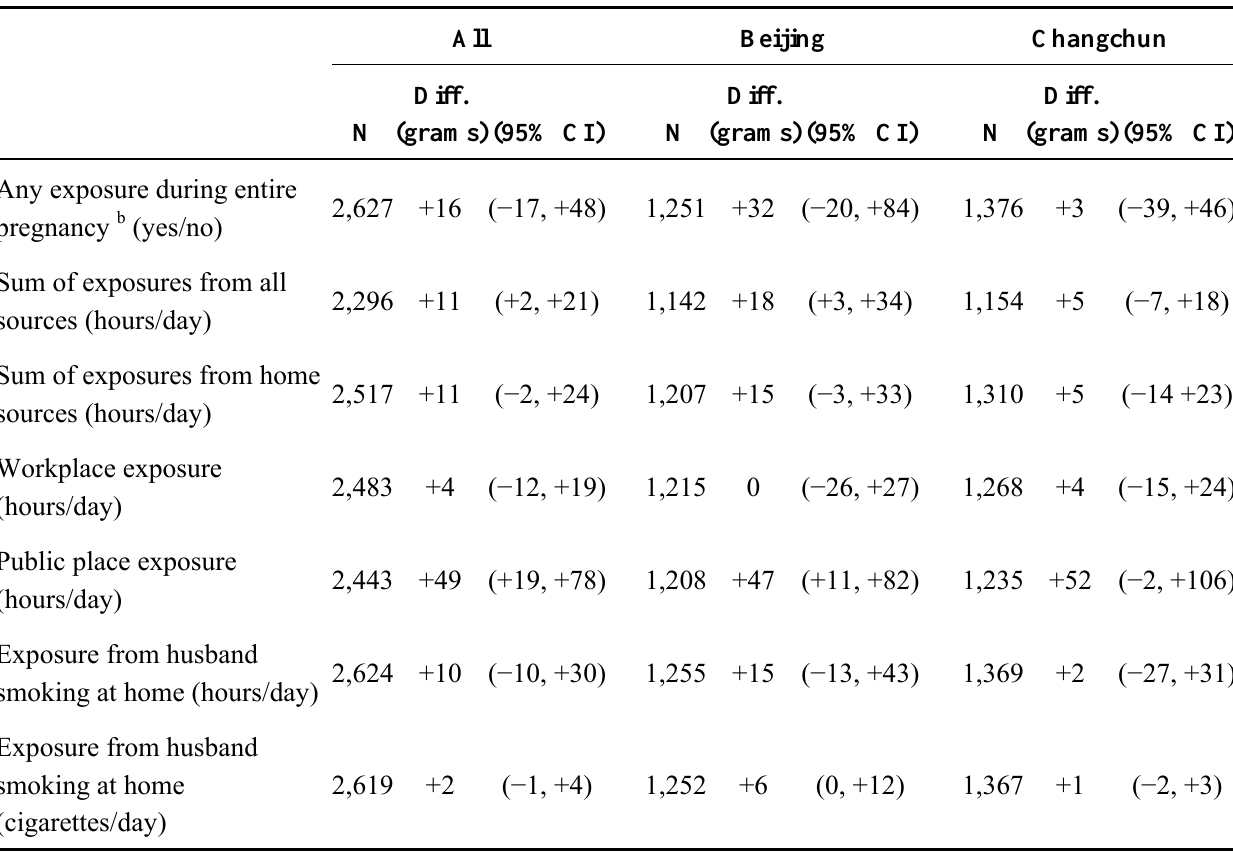
Table 8. Adjusted a mean differences in birth weight for self-reported exposures to SHS during third trimester of pregnancy, by